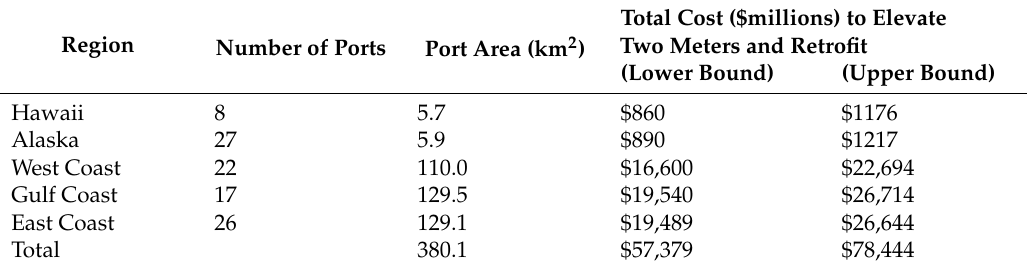
Table 10. Total cost to elevate all US coastal port infrastructures by two meters.